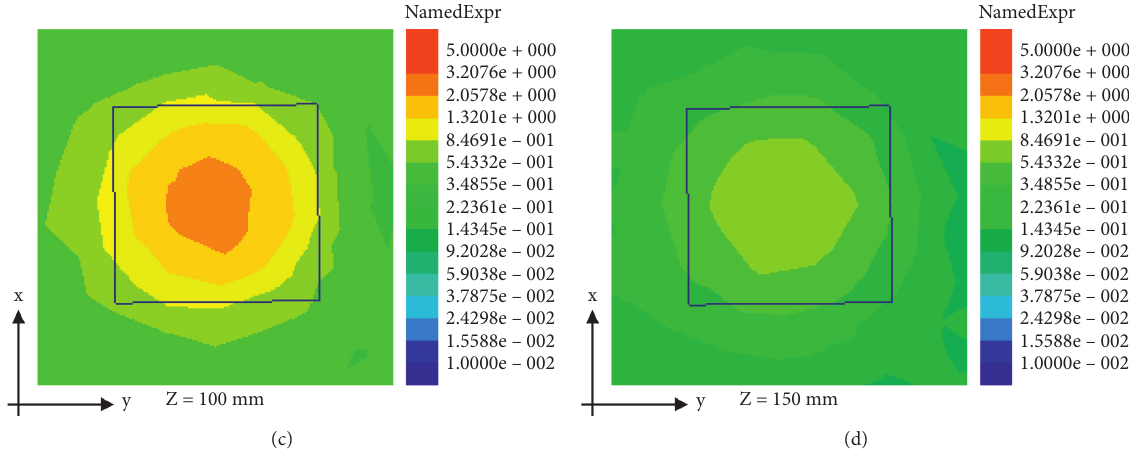
Figure 19: Simulated Ez distributions of the three-branch antenna at different heights when the dielectric constant is 3. (a) Z � 30mm. (b) Z � 50mm. (c) Z � 100mm. (d) Z � 150mm.